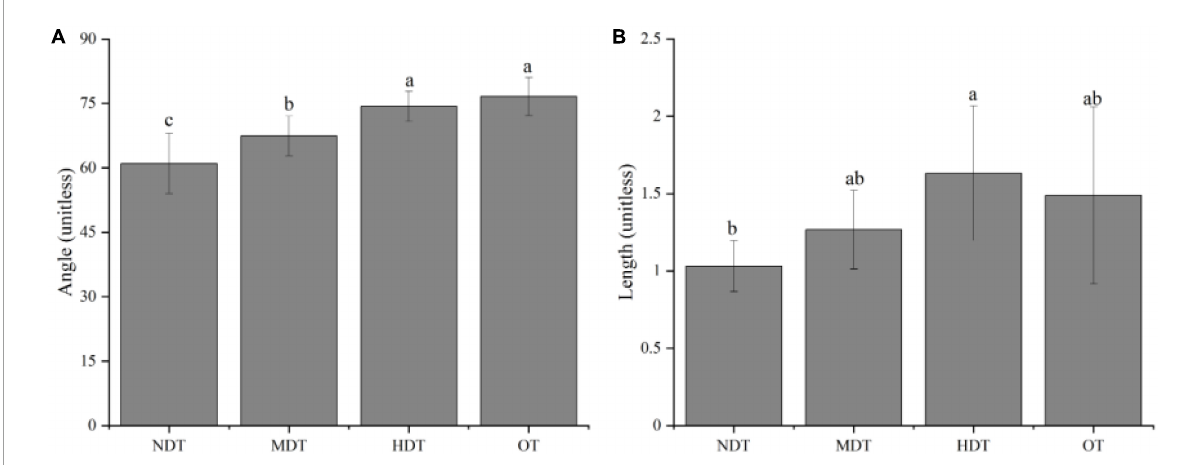
FIGURE2 The vector angles (A) and lengths (B) under different types of karst tiankeng. NDT, non-degraded tiankeng; MDT, moderately degraded tiankeng; HDT, heavily degraded tiankeng; OT, outside tiankeng. Different lowercase letters indicate significant differences between means for different types of karst tiankeng ( P < 0.05).